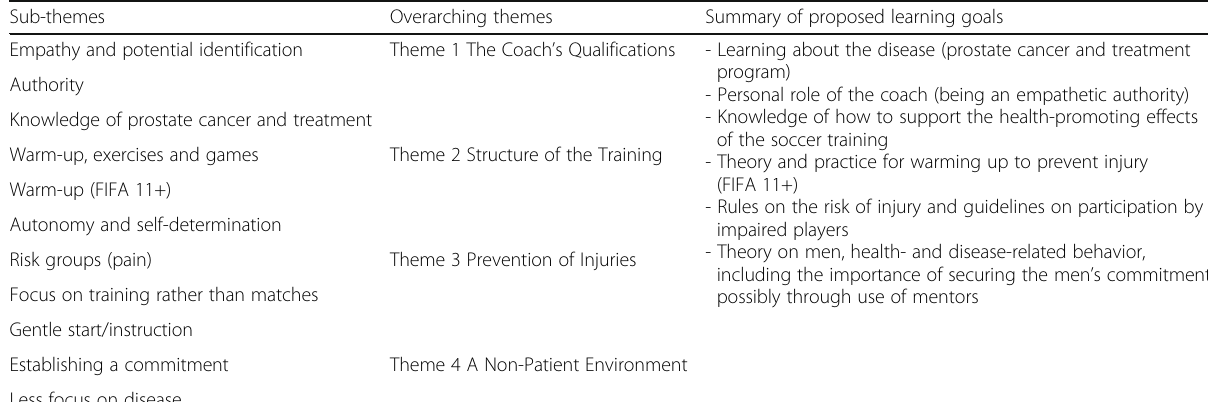
Table 3 Overview of findings in step 1